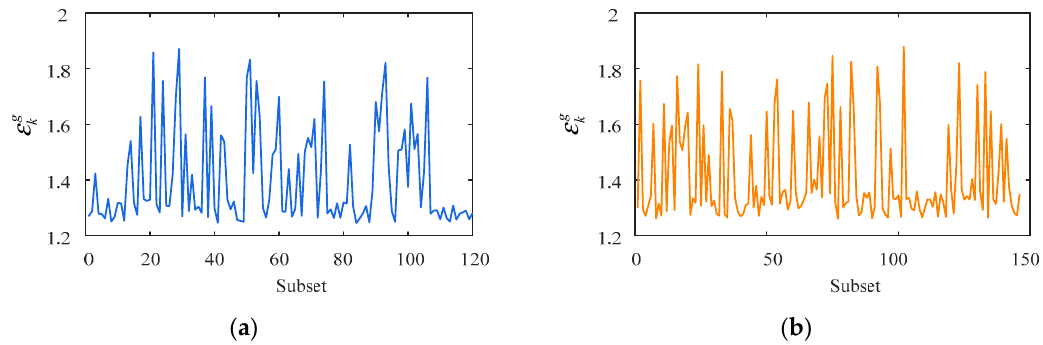
ε of each subset in different time windows. ( a ) Five days; ( b ) one of each subset in different time windows. ( a ) Five days; ( b ) one year. k k